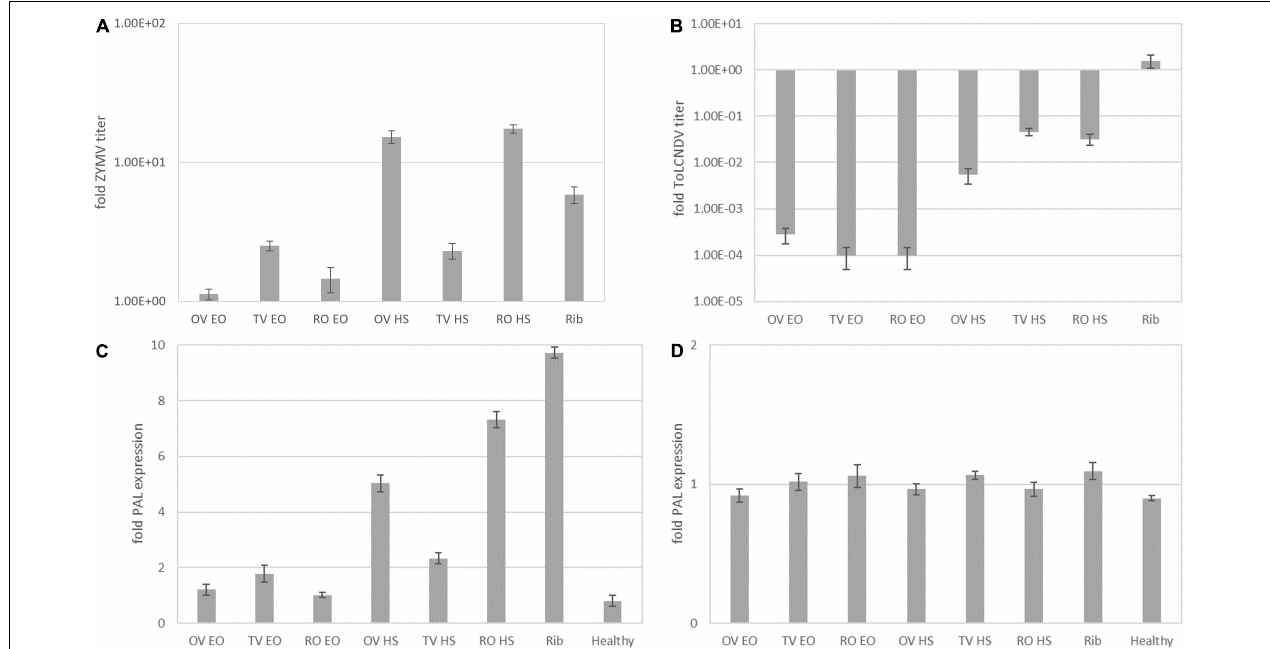
FIGURE 1 | Fold change of zucchini yellow mosaic virus coat protein (ZYMV-CP) (A) , tomato leaf curl New Delhi virus (ToLCNDV)-A (B) , and relative expression of phenylalanine ammonia lyase (PAL) in ZYMV-infected treated (C) and ToLCNDV-infected treated (D) at 5 d.p.i. with respect to infected no-treatment control. OV EO, O. vulgare essential oil; TV EO, T. vulgaris essential oil; RO EO, R. officinalis essential oil; OV HS, O. vulgare hydrosol; TV HS, T. vulgaris hydrosol; RO HS, R. officinalis hydrosol; Rib, ribavirin; Healthy, mock-inoculated plants. Columns represent mean value from 2 technical replicates on 3 pooled biological replicates, and bars indicate standard error ( ±